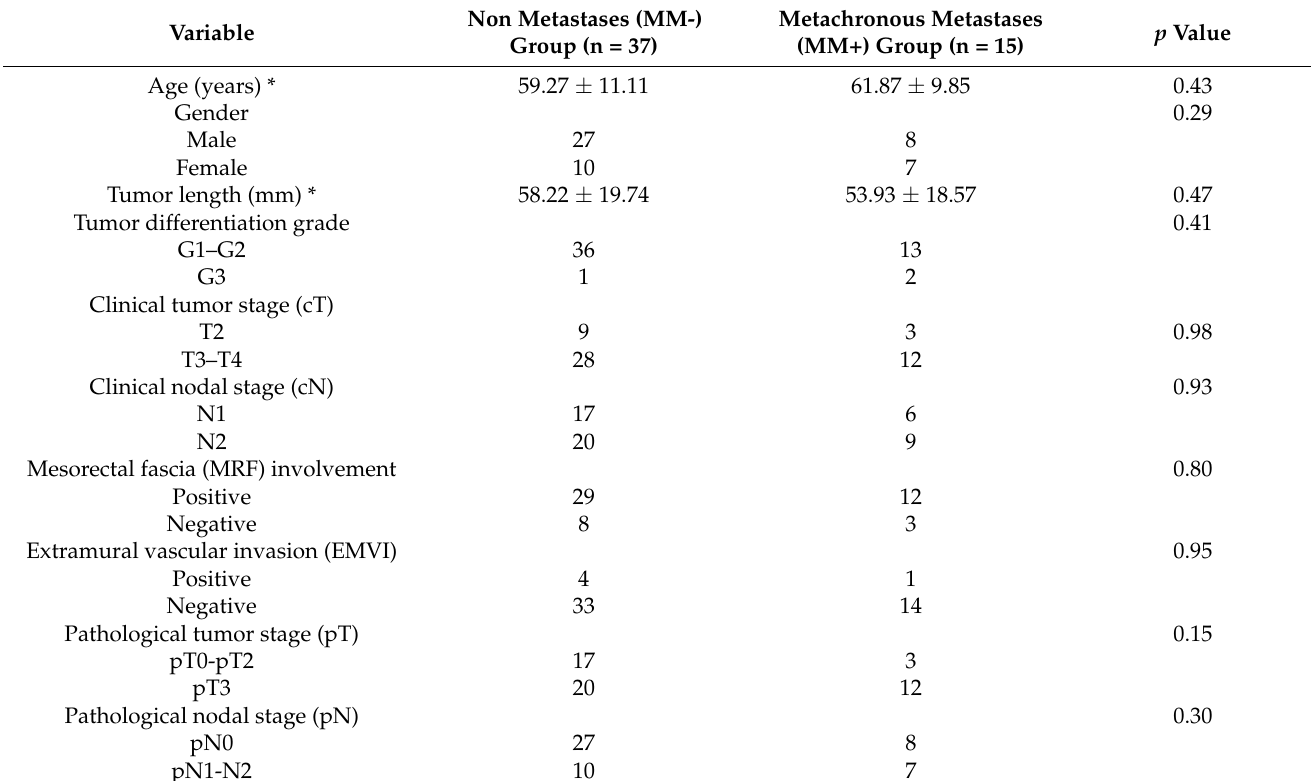
Table 3. Clinical and histopathological characteristics of the study population.